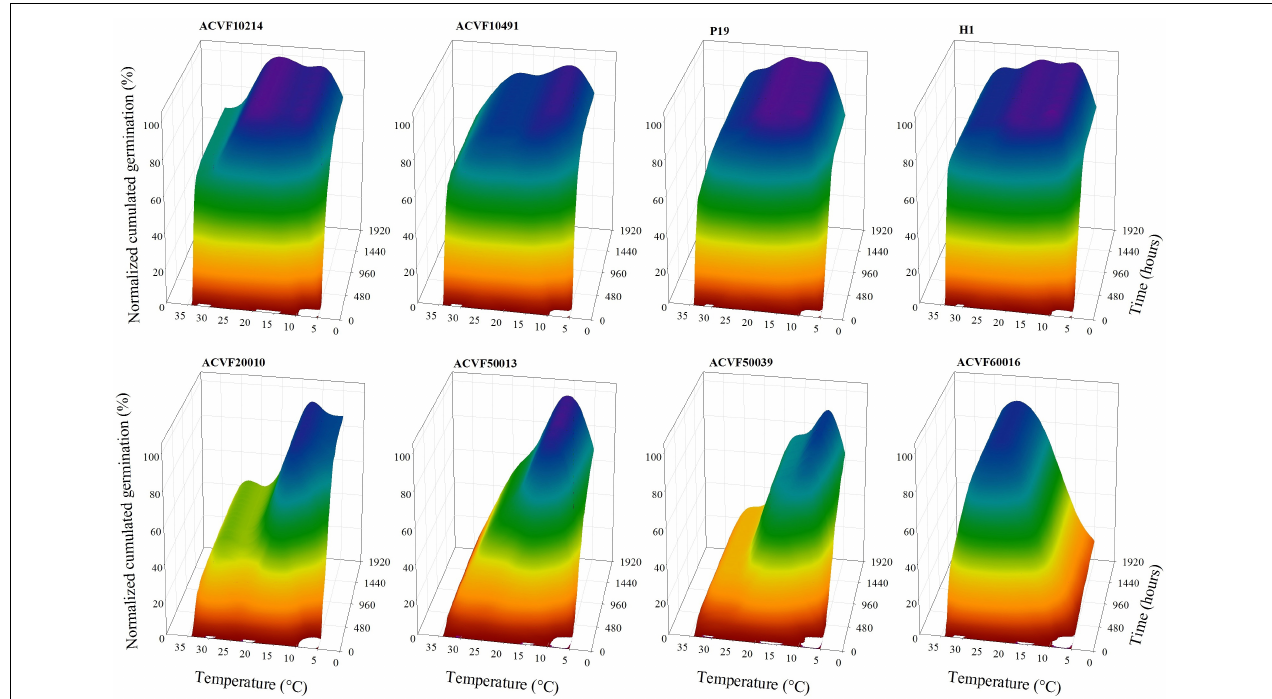
FIGURE 1 | Temperature and time course response surfaces of the normalized cumulative germination percentage of eight accessions of Lolium perenne